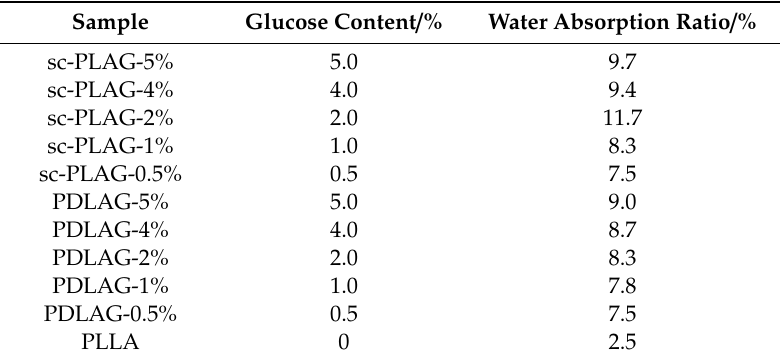
Table 5. Hydroscopic property of PLLA and sc-PLAG